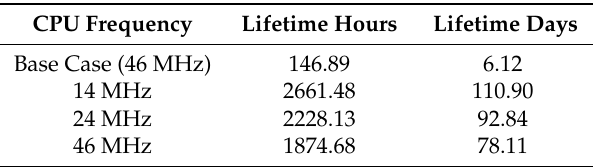
Table 5. BLE battery life